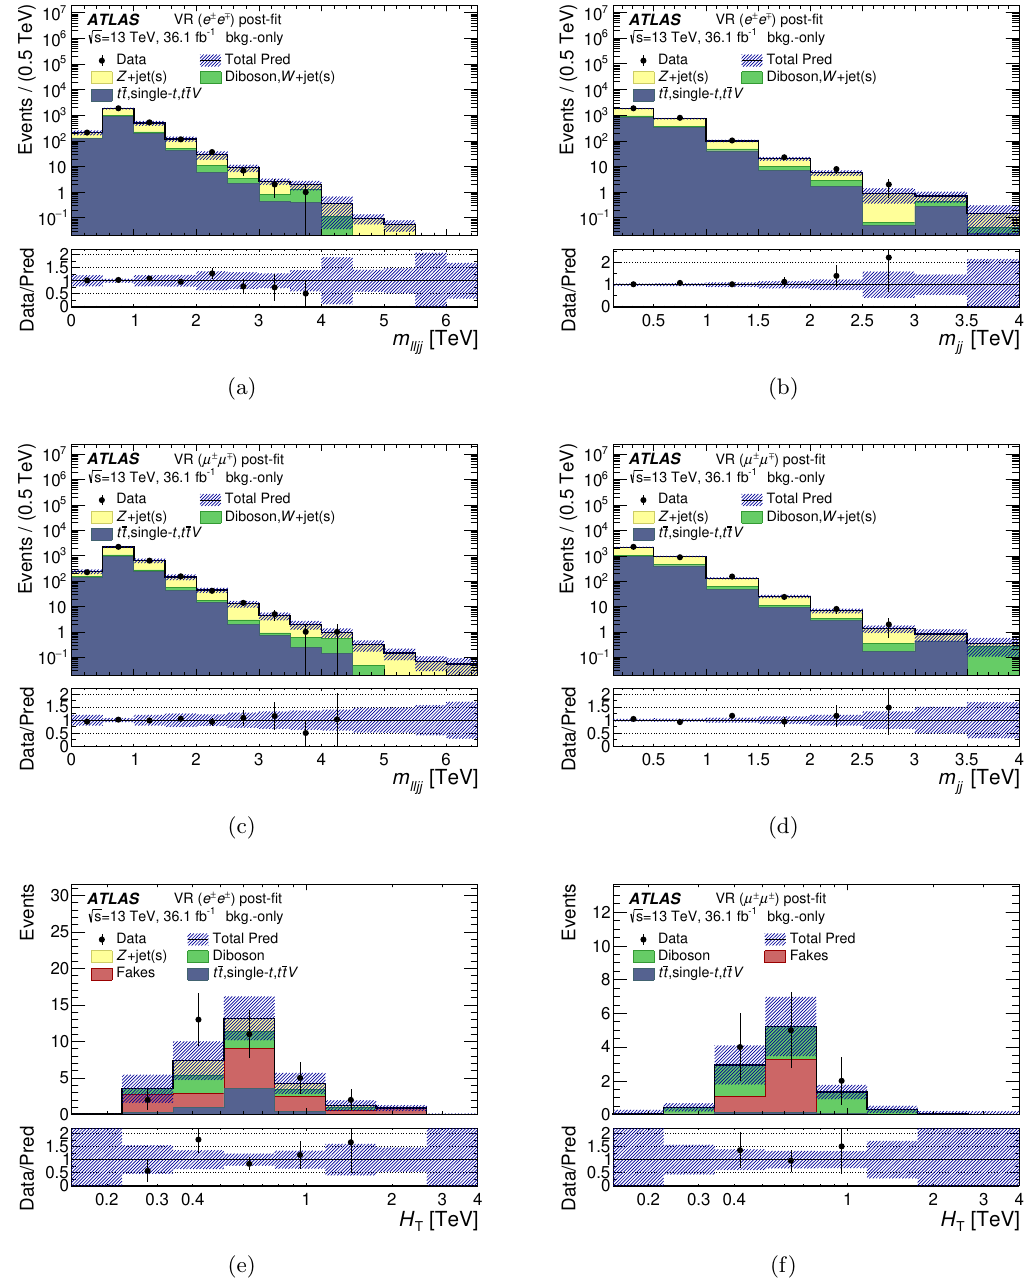
Figure 5 . Distributions for data and background predictions for discriminant variables in various validation regions and channels after the background-only (cid:12)t: (a) m ‘‘jj in VR( e (cid:6) e (cid:7) ), (b) m jj in VR( e (cid:6) e (cid:7) ), (c) m ‘‘jj in VR( (cid:22) (cid:6) (cid:22) (cid:7) ), (d) m jj in VR( (cid:22) (cid:6) (cid:22) (cid:7) ), (e) H T in VR( e (cid:6) e (cid:6) ), and (f) H T in VR( (cid:22) (cid:6) (cid:22) (cid:6) ). The hatched bands include all post-(cid:12)t systematic uncertainties. The correlation between sources of systematic uncertainties are taken into account. The last bin in each histogram contains the over(cid:13)ow.